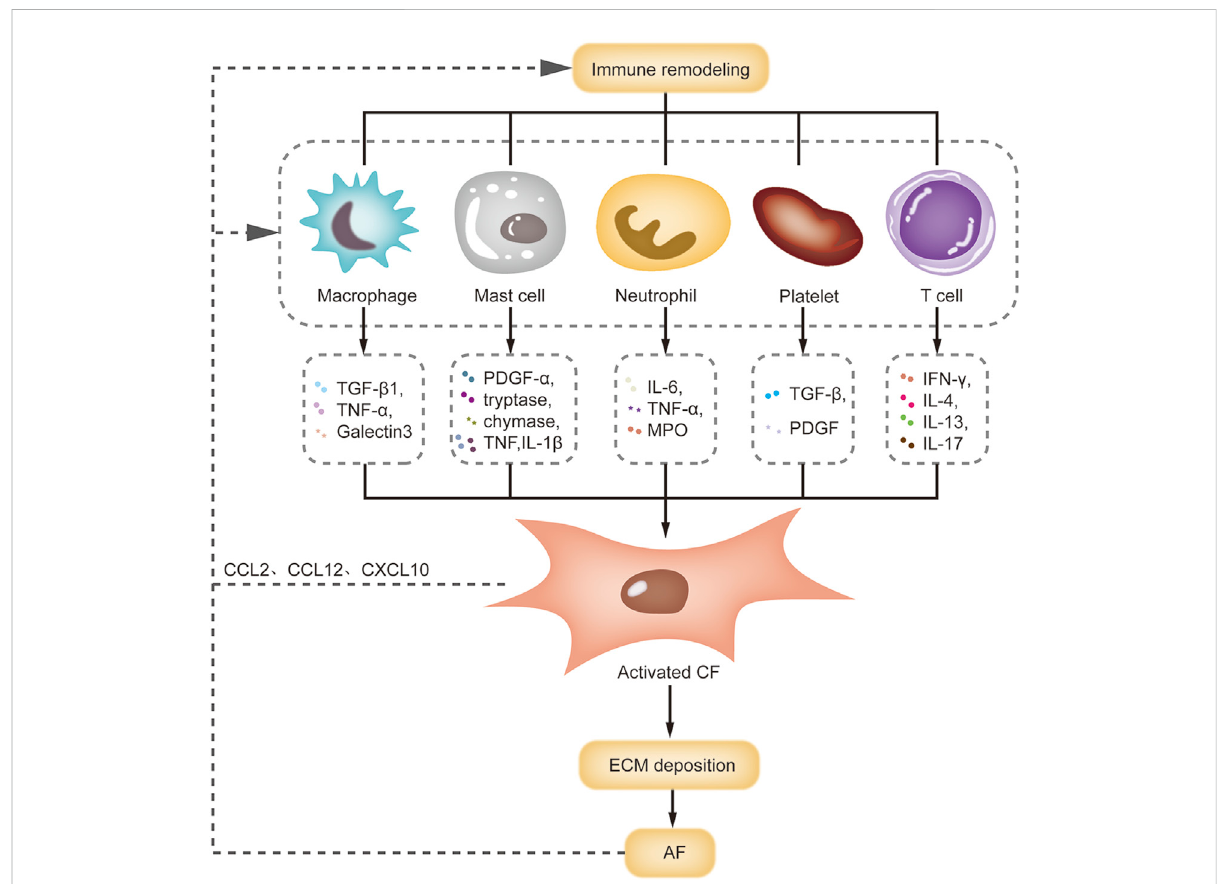
FIGURE 3 Interactions of immune remodeling and structural remodeling. This fi gure summarizes the interactions between immune cells and CF during AF. Macrophage, mast cell, neutrophil and T cell can release pro- fi brotic factors to activate CF, leading to ECM deposition and atrial structural remodeling.Meanwhile,activatedCFcanpromotethemacrophagerecruitmentbyreleasingchemokines.Abbreviations:CCL,C-Cmotifligand;CF, cardiac fi broblast; CXCL, C-X-C motif ligand; ECM, extracellular matrix; IFN- γ , interferon- γ ; IL-4, interleukin-4; MPO, myeloperoxidase; PDGF, platelet-derived growth factor; TGF- β , transforming growth factor- β ; TNF- α , tumor necrosis factor- α